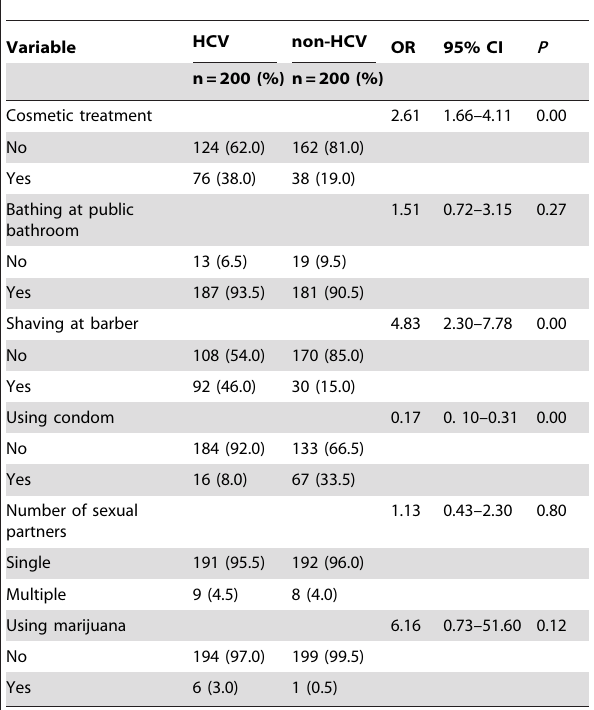
Table 2. Risk factors related to community and sexual behaviour among HCV and non-HCV